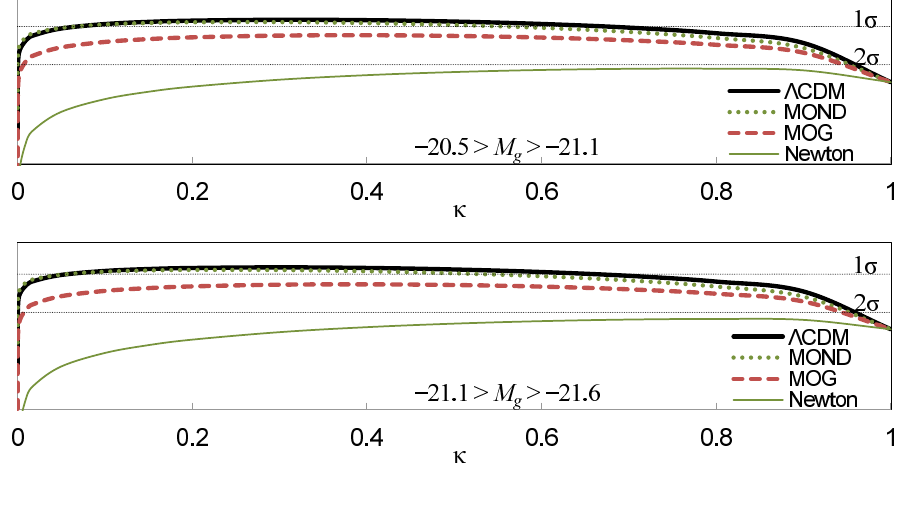
Figure 2. Likelihood of Λ CDM, Modified Newtonian Dynamics (MOND), Modified Gravity Theory (MOG), and the Newtonian model without exotic dark matter, as a function of the > − 21 . 1 , bottom : − 21 . 1